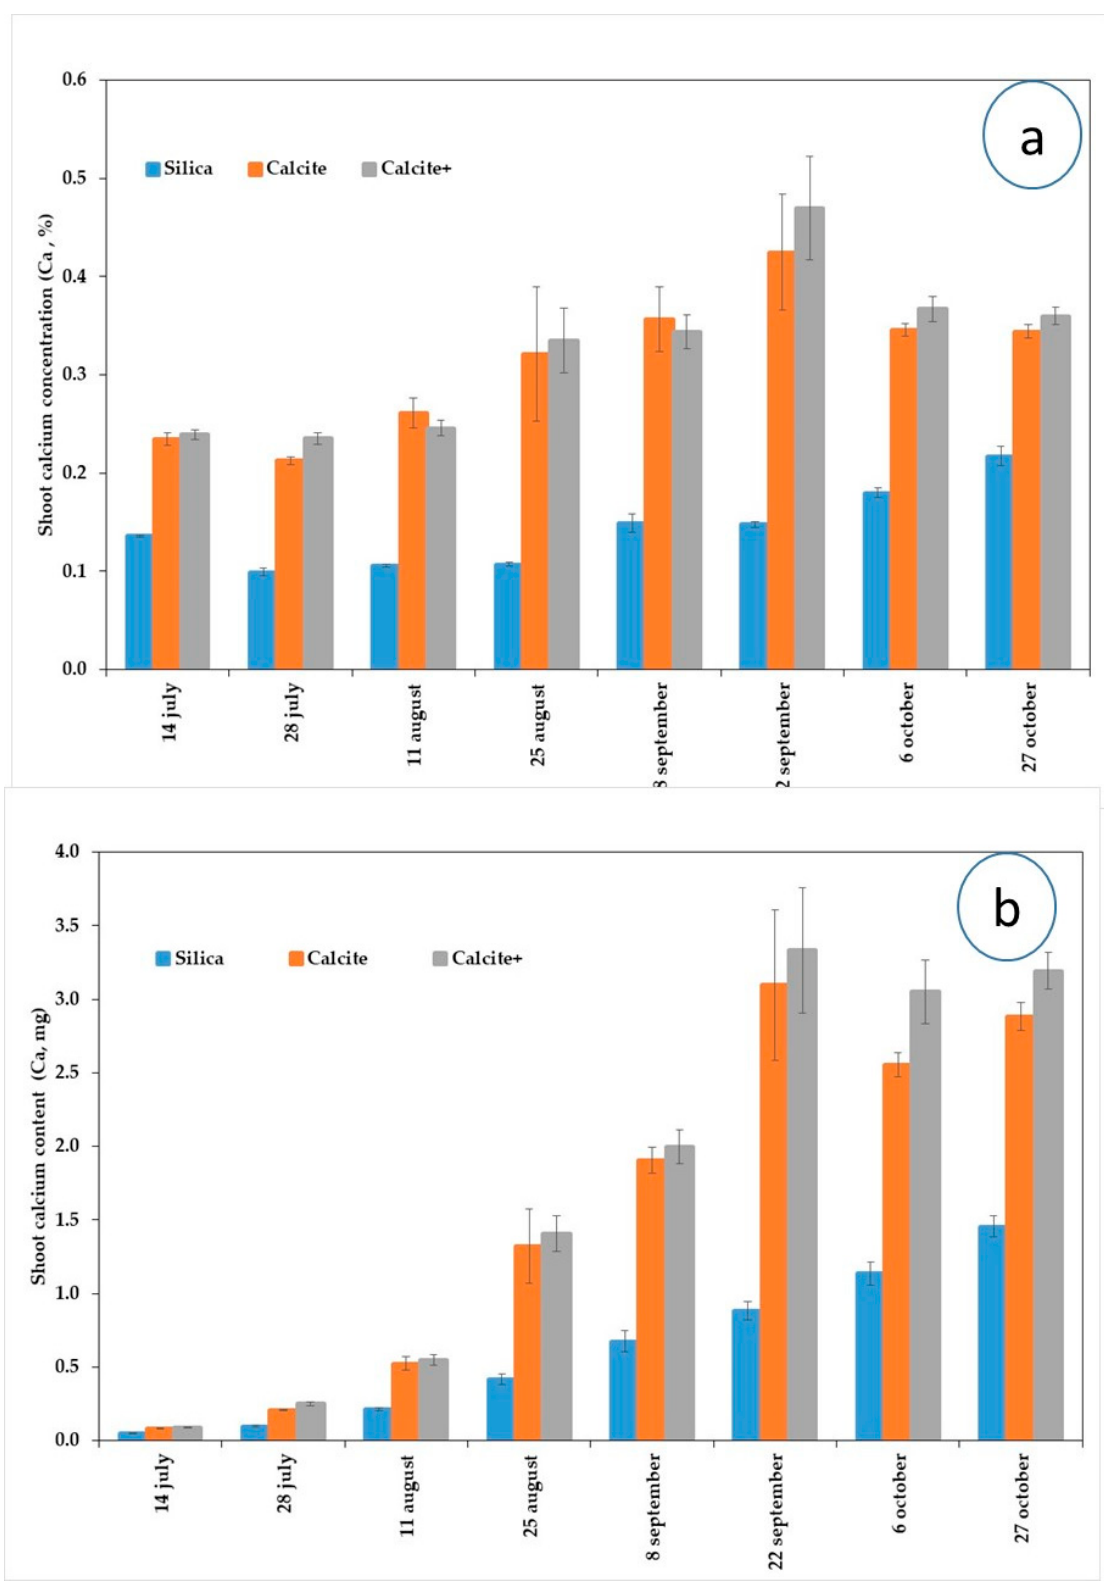
Figure 10. Variations ( a ) in the calcium concentration (Ca, %), and ( b ) in the calcium content (Ca, mg) in the shoots during the first growing season of white spruce seedling (1 + 0) depending on the covering material (silica: 29 g/cavity, calcite: 24 g/cavity and calcite+: 31 g/cavity).